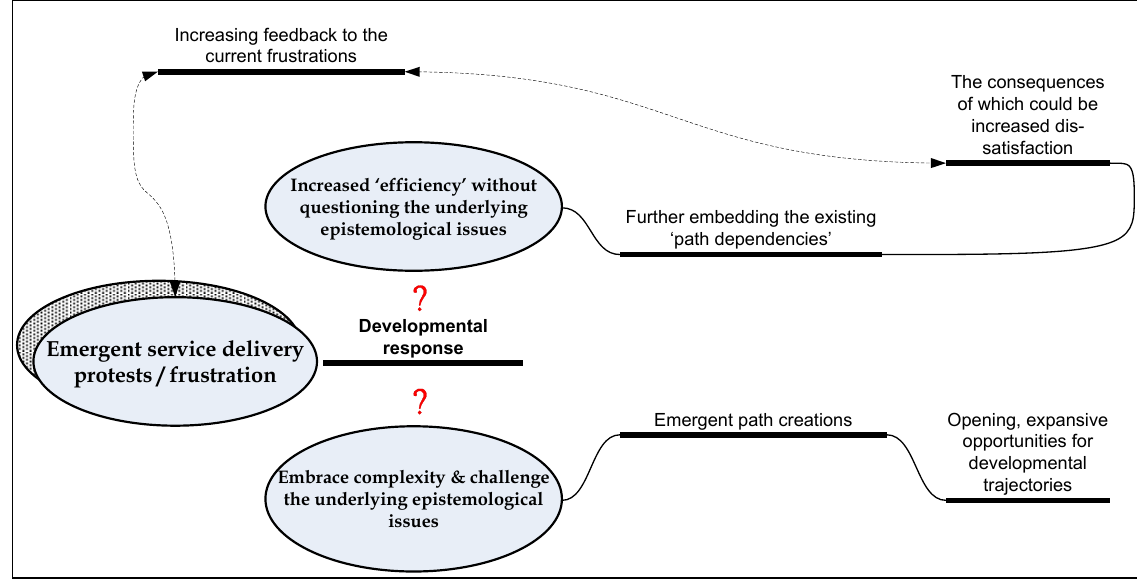
Figure iv: The complex tipping point for the South African development apparatus. Source: authors’